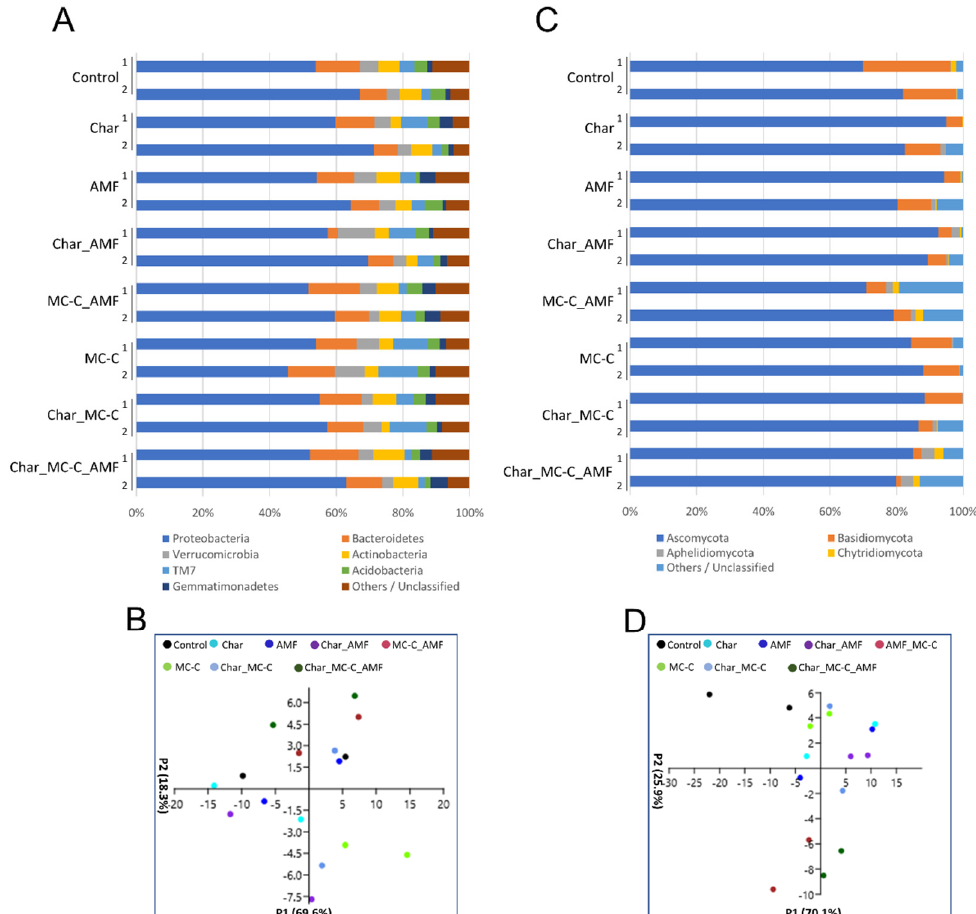
Figure 2. Phyla of rhizospheric bacterial and fungal communities in wheat soils untreated or treated with different combinations of biofertilizers. ( A ) Relative abundance (based on OTUs) of the most relevant bacterial phyla found in eight rhizospheric soils of wheat analyzed in duplicate (1–2); the colors are ordered from left to right according to the legend reported at the bottom of the panel; ( B ) PCA analysis of the eight selected bacterial communities in the different wheat soils analyzed. ( C ) Relative abundance (based on OTUs) of the most relevant fungal phyla found in eight rhizospheric soils of wheat analyzed in duplicate (1–2); the colors are ordered from left to right according to the legend reported at the bottom of the panel. ( D ) PCA analysis of eight selected fungal communities in the different wheat samples analyzed. Each symbol (circle) represents one replicate and the colors follow the legend reported at the top of the